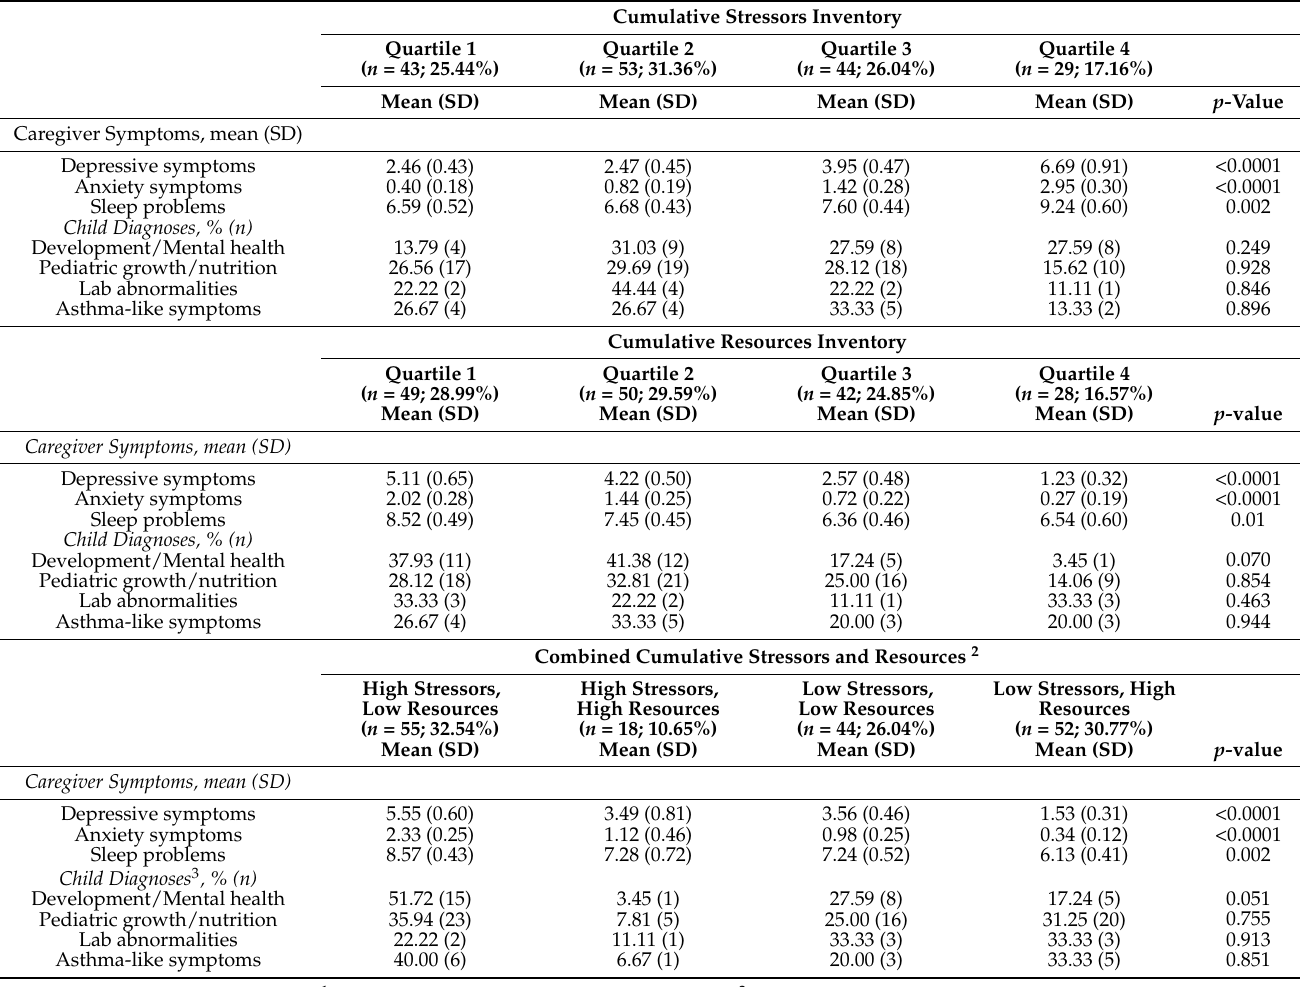
Table 4. Bivariate Associations between Caregiver and Child Health Conditions by Stressors and Resources 1